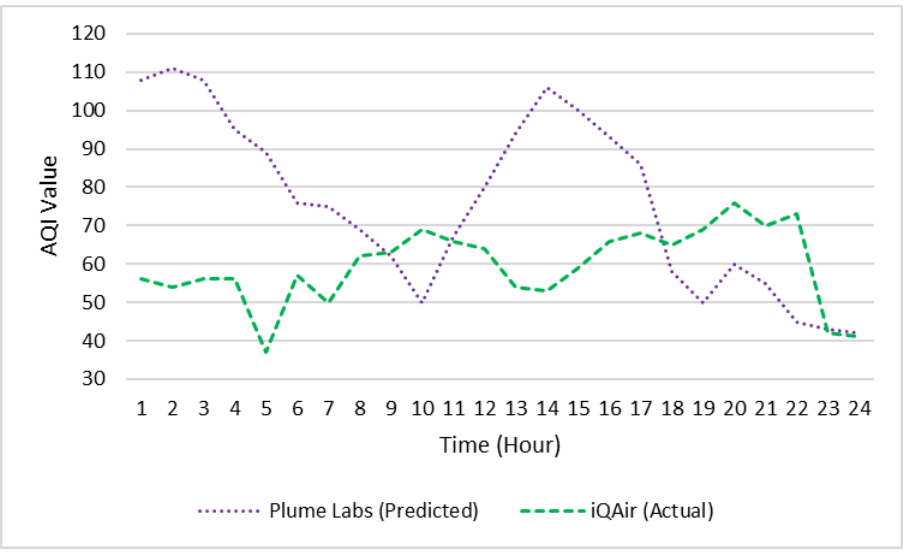
Figure 1. Predicted and actual AQI values for the Kuala Lumpur region for 24 h.